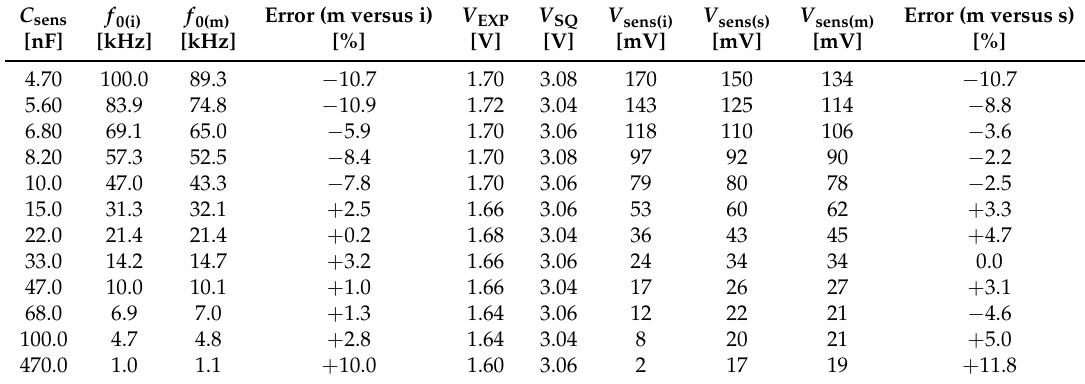
Table 2. Comparison of the obtained results—Mathcad simulations and